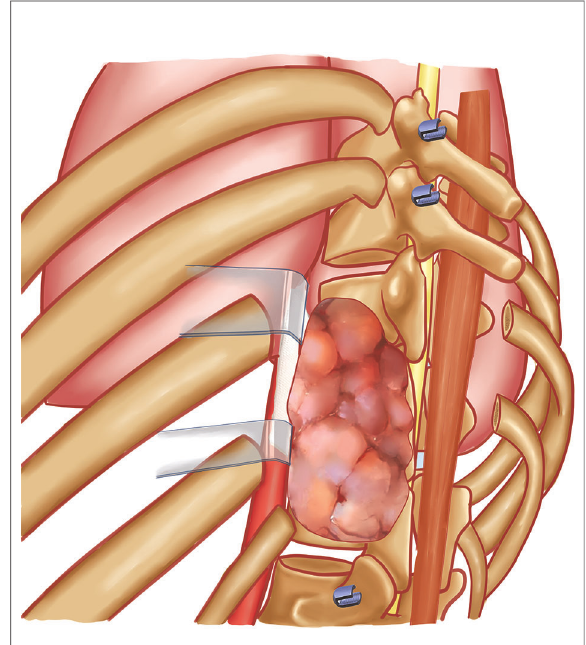
FIGURE 3 General view of the surgical procedure: the rib(s) connected to the involved vertebrae were cut. Blunt dissection was performed around the vertebral body and mass. The inferior and superior intervertebral discs and anterior longitudinal ligament was cut. The tumor was turned over and pulled out from the mass lateral of spinal